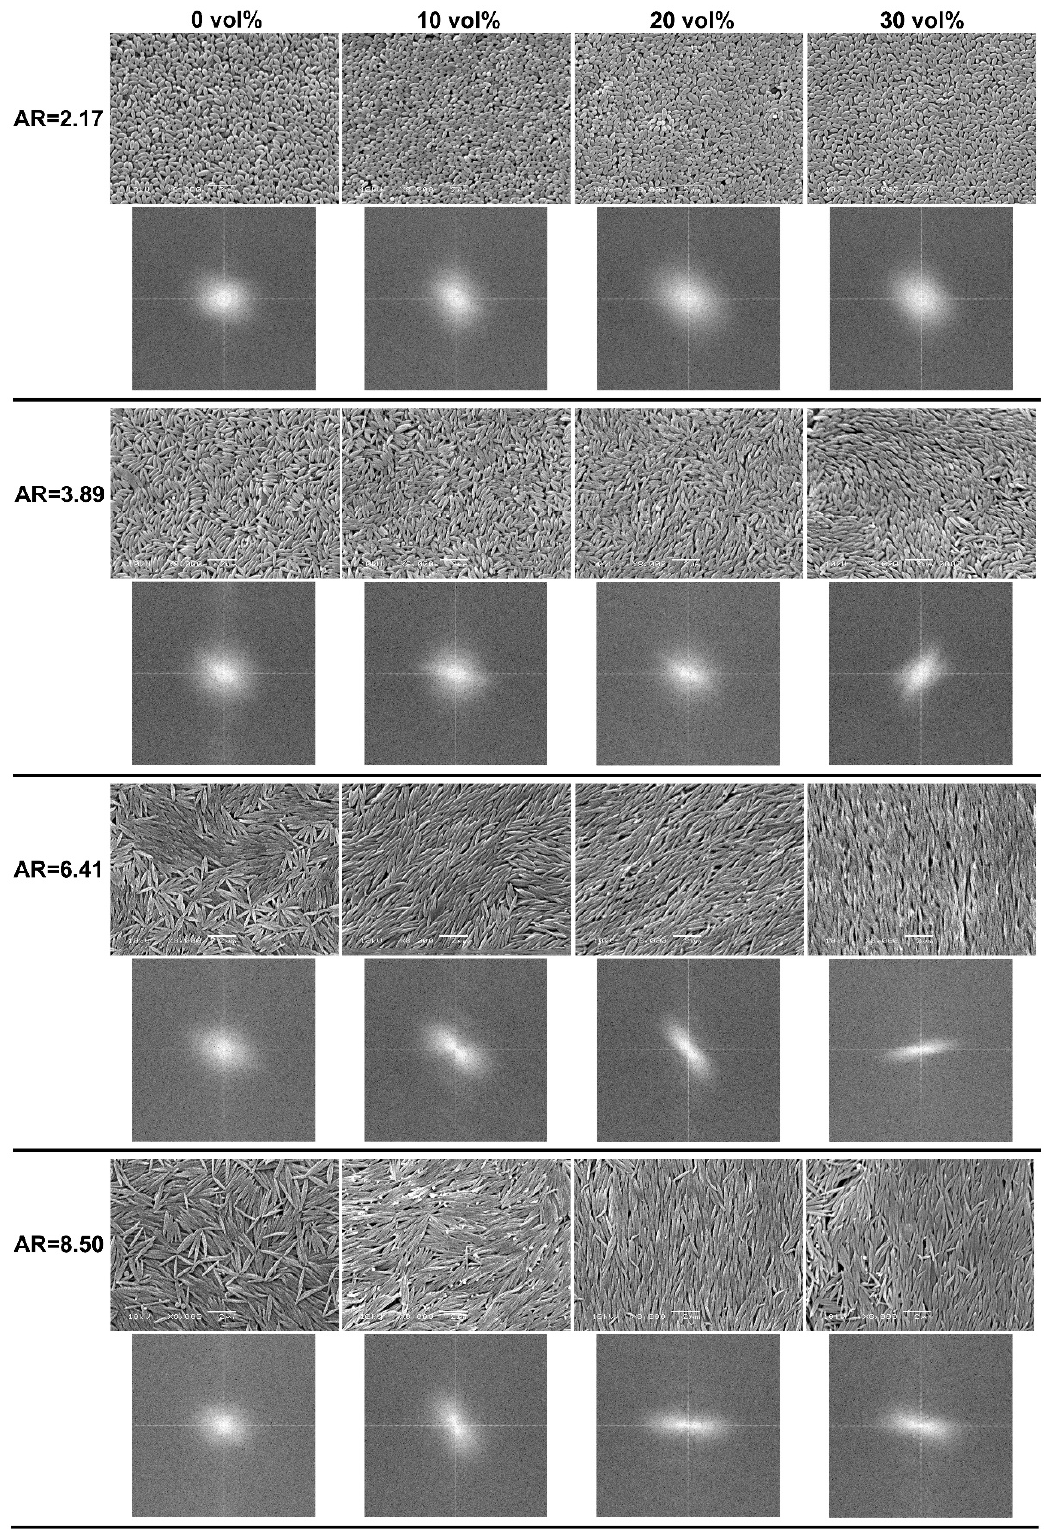
Figure 3. Representative SEM images of top layer of multilayered assemblies of P(S/PGL) micro- spheroids with various aspect ratios ( AR ) and concentration (0–30%) of ethanol in aqueous particle suspension and corresponding two-dimensional fast Fourier transformation (FFT) images.